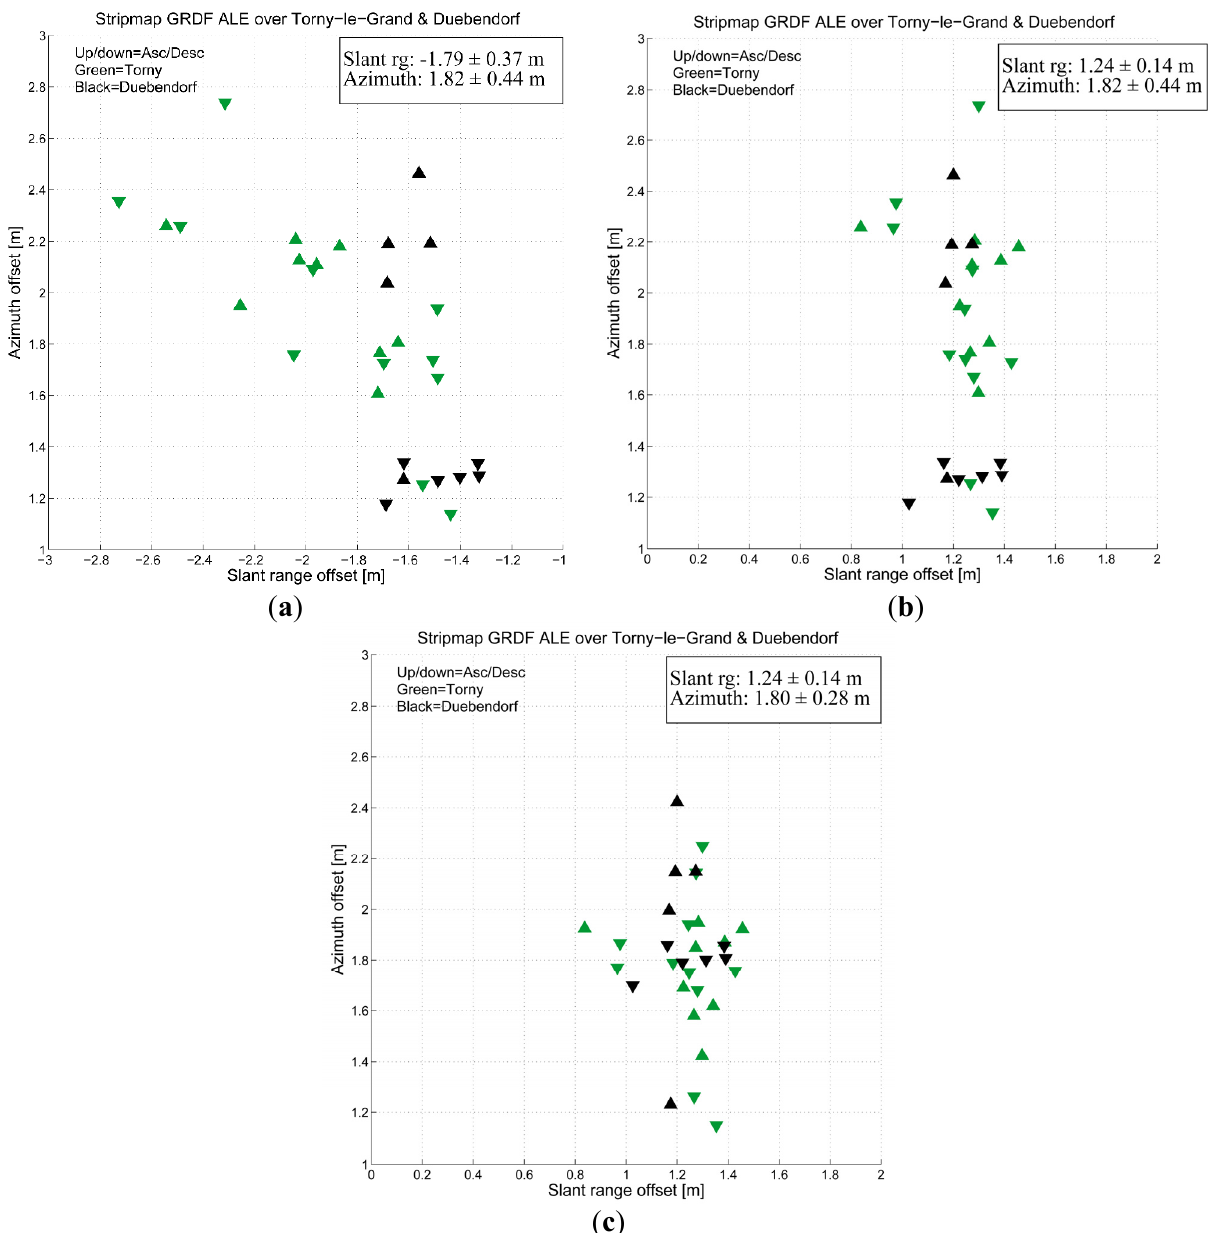
Figure 7. StripMap GRDF estimates using precise state vectors; each point represents a single product over Torny-le-Grand (green) or Dübendorf (black); ( a ) no path delay or bistatic residual corrections; ( b ) path delay correction but no bistatic residual correction; ( c ) path delay and bistatic residual corrections applied. (a) no PD, no bistatic; (b) PD, no bistatic; (c) PD,